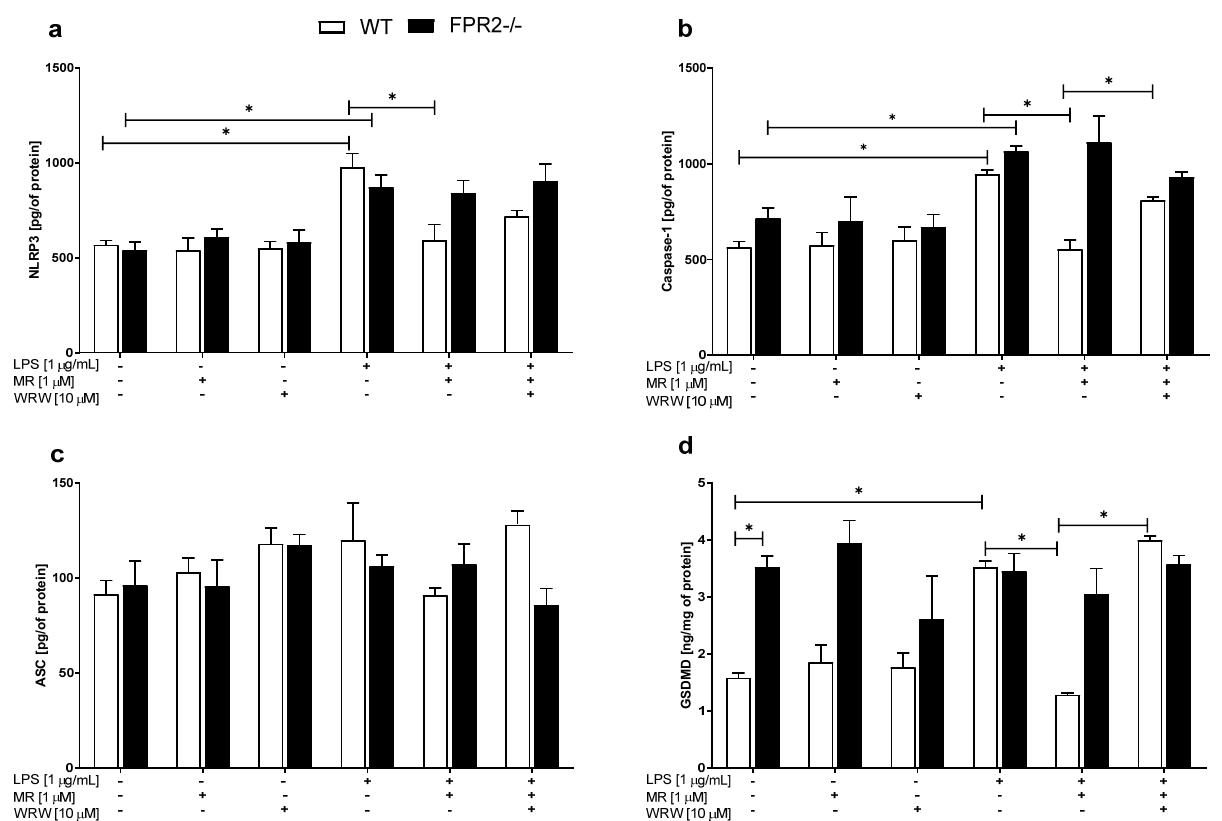
Figure 6. The effects of LPS and/or MR-39 and WRW4 on the levels of proteins involved in the NLRP3 inflammasome signaling pathway ( a —NLRP3; b —Caspase-1; c —ASC, d —GSDMD) in organotypic hippocampal cultures (OHCs) derived from the offspring of wild-type (WT) and FPR2 − / − (KO) mice. OHCs obtained from WT and KO mice were pretreated with the FPR2 antagonist WRW4 (10 µ M) for 30 min. Afterward, MR-39 (1 µ M) was added and incubated for 1 h, and then OHCs were stimulated with lipopolysaccharide (LPS; 1 µ g/mL) for 24 h. Control cultures were treated with the appropriate vehicle. The results are presented as the means ± SEM. The data were obtained from three independent experiments. The results were statistically evaluated using a factorial analysis of variance (ANOVA) with Duncan’s post hoc test to assess the differences between the treatment groups. Significant differences are indicated by * p < 0.05. ASC—apoptosis- associated speck-like protein containing a caspase recruitment domain; NLRP3—Nod-like receptor pyrin-containing 3 subunit; GSDMD—gasdermin D. +—with LPS, MR or WRW treatment; -—without LPS, MR or WRW treatment.